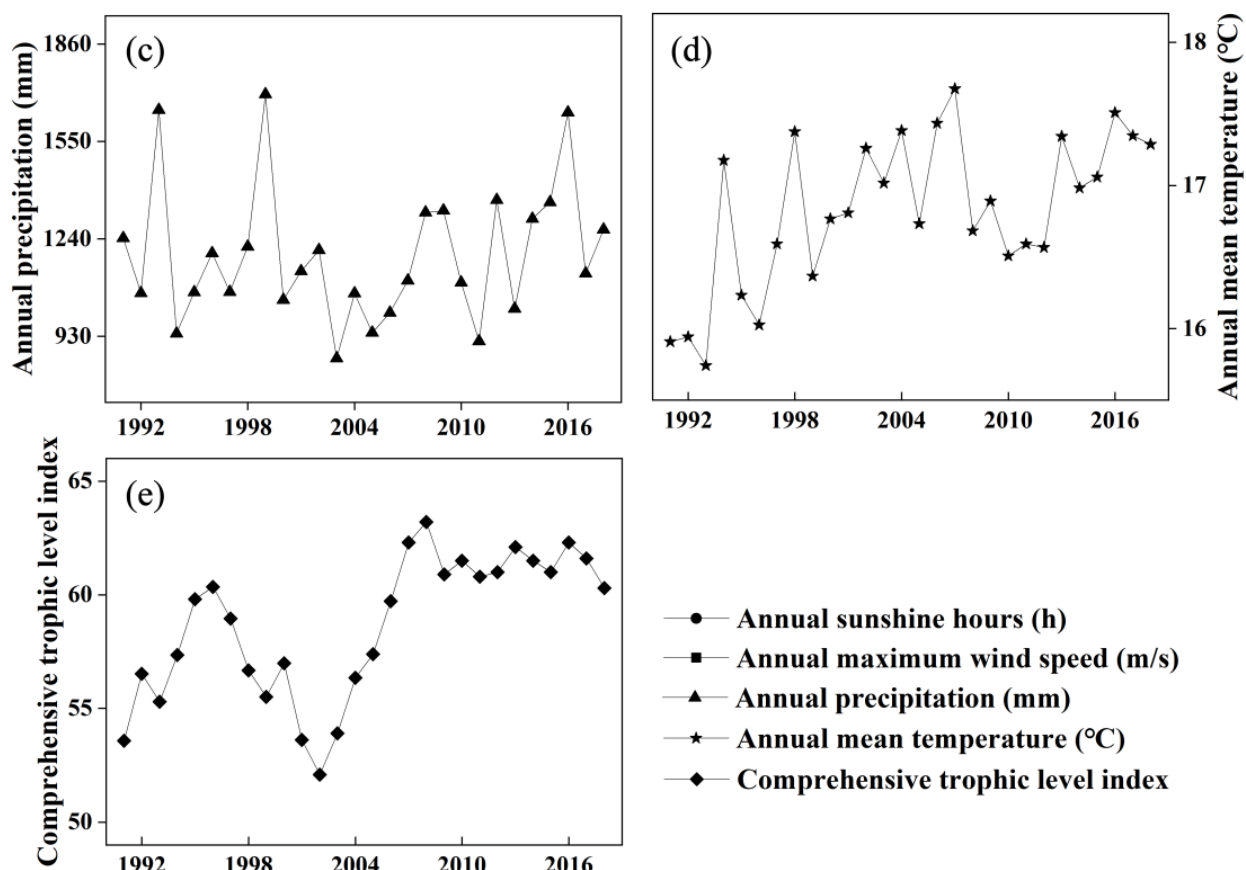
Figure 9. Interannual change in ( a ) annual sunshine hours (SH); ( b ) annual maximum wind speed (WS); ( c ) annual precipitation (P); ( d ) annual mean temperature (T); ( e ) comprehensive trophic level index (TLI) during 1991 – 2018 in Taihu Lake.